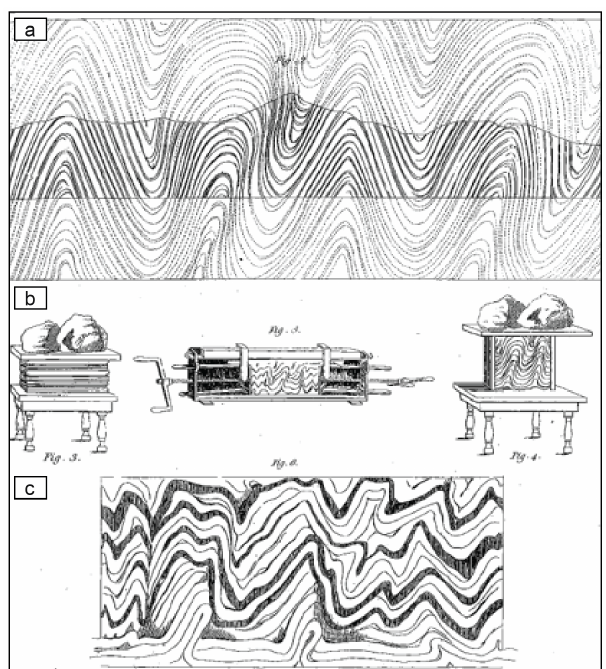
Figure 2. Reproduction of Plate IV from Hall (1815). A series of images depict a set of experiments which have since inspired the use of analogue materials to provide a physical explanation for geologi- cal observations made in the field. Hall produced an “ideal” coastal section (a) to demonstrate the continuous nature of the folded rock layers observed in the field. Sketches depict a set of experiments that were performed (b) by compressing clay layers to produce con- volutions (c) that are reminiscent of the structures observed in the